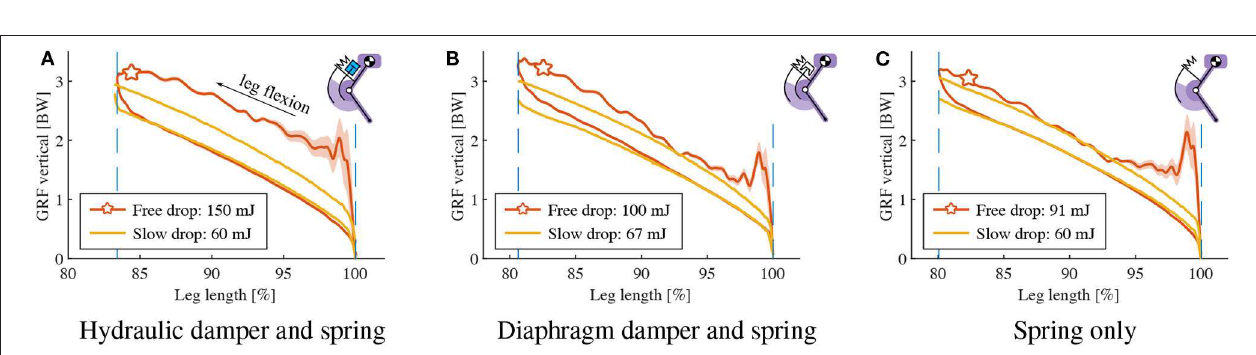
FIGURE 7 | Characterizing the hydraulic damper. A single damper (not leg-mounted) drops onto the force sensor. 10 repeated experiments are plotted as an envelop, defined by the average ± 95% of the standard deviation data. The curves are read from right to left, i.e.from touch-down at maximum speed to zero speed at rest, also corresponding to the maximum damper compression. (A) 280 grams drop mass with medium orifice in 3 drop heights. (B) 280 grams drop mass with 5cm drop height in 3 orifice settings. (C) Three centrimeter drop height with medium orifice in 2 drop weights.